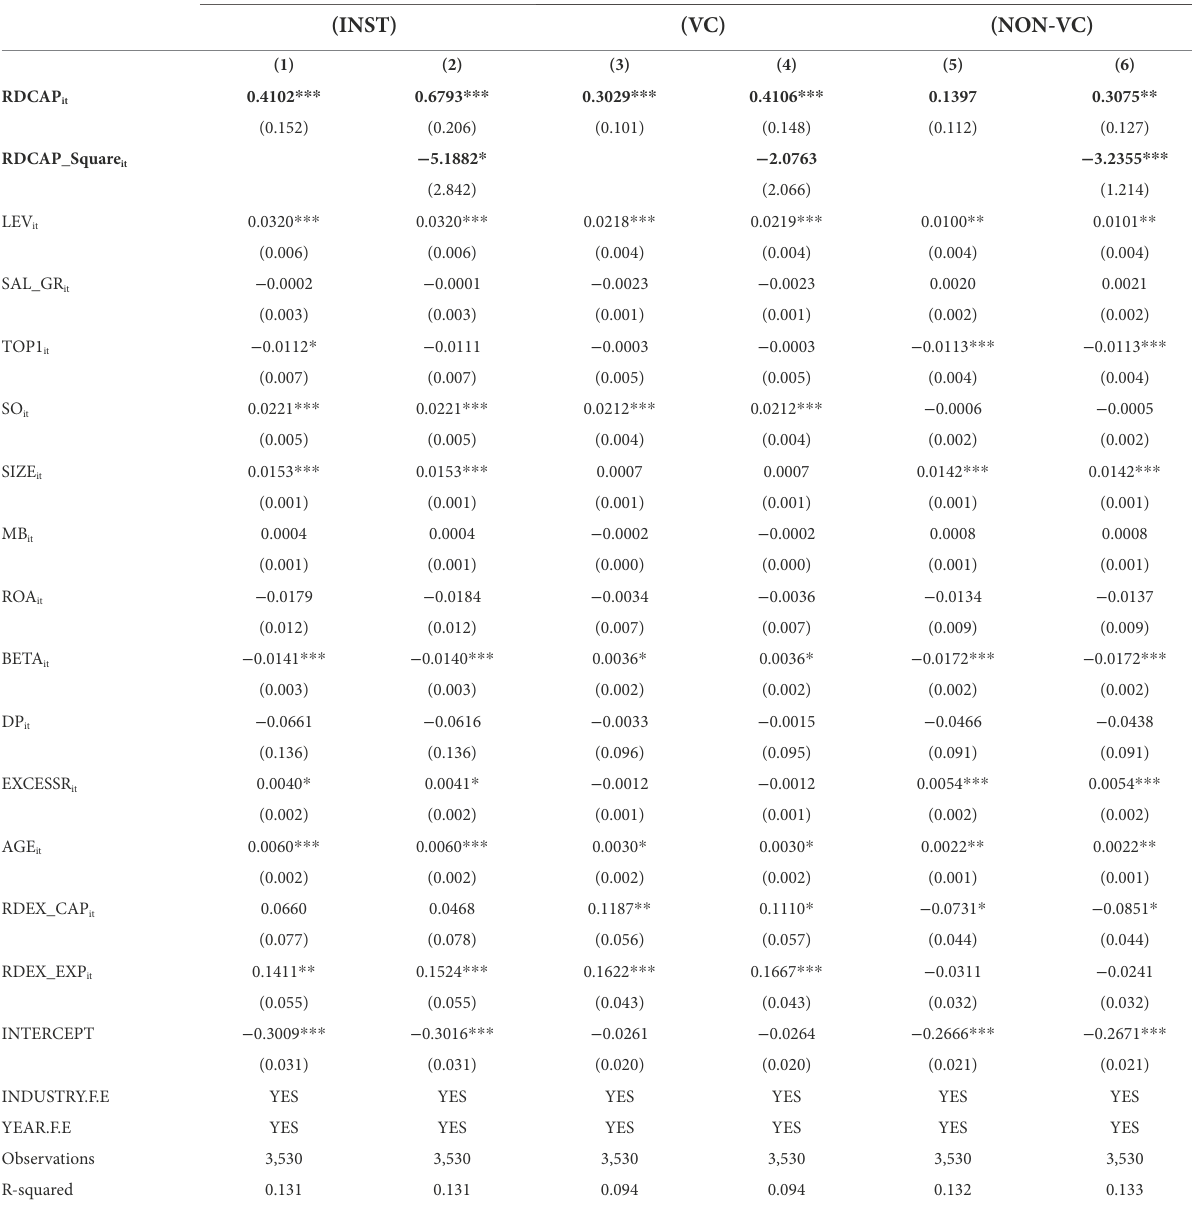
TABLE 4 Future institutional investment and R&D